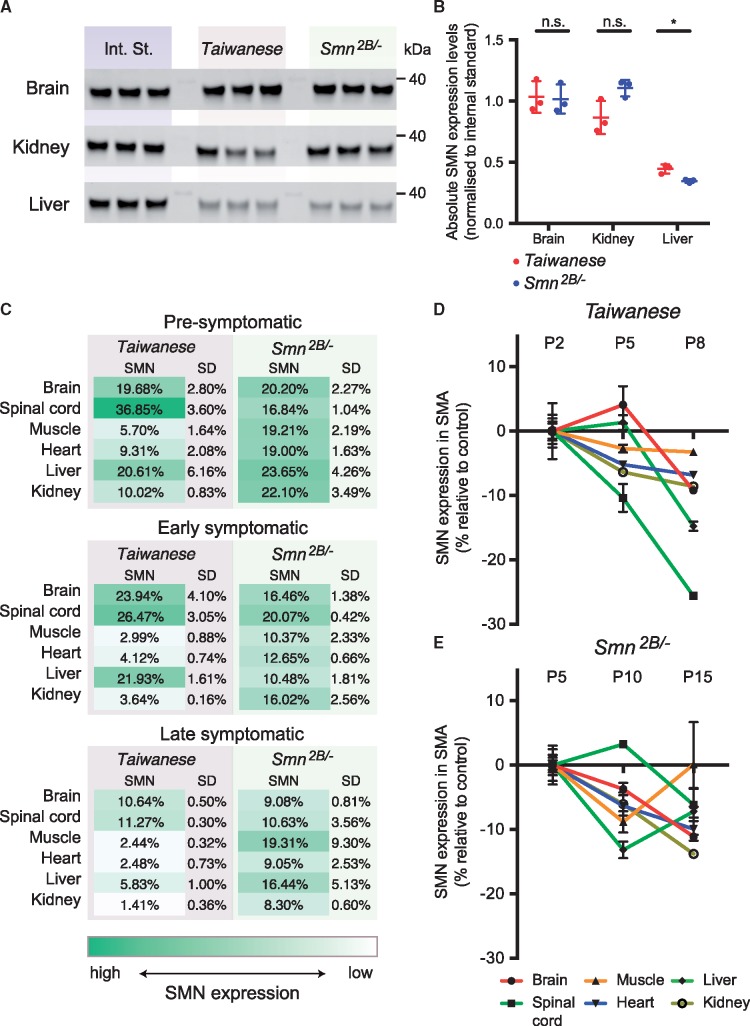

 Comparison of SMN levels between the Taiwanese and Smn2B/− models of SMA. (A) SMN expression was determined by western blot in the indicated tissues at P5 in both mouse models. Shown are the Int. St. that was the same for each tissue and loaded in triplicate on each membrane, and SMN expression in triplicate for each tissue. kDa: 40 kDa molecular weight marker. (B) Quantification of SMN expression from the blots in (A), *P < 0.05 (t-test). Expression was first normalized to a fluorescent TPS and then to the Int. St., to allow direct comparison between membranes. (C) Average of remaining SMN levels (± SD) in both mouse models at each of the investigated time points and tissues. (D) Relative depletion in SMN expression over time in Taiwanese mice. To allow easier comparison between tissues, P2 was set as 0 and expression values at P5 and P8 are shown relative to P2. (E) Relative depletion in SMN expression over time in Smn2B/− mice. To allow easier comparison between tissues, P5 was set as 0 and expression values at P10 and P15 are shown relative to P5.